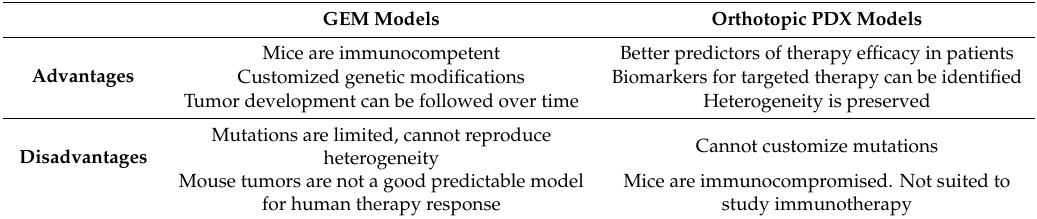
Table 2. Genetically engineered mouse (GEM) models compared to orthotopic PDX